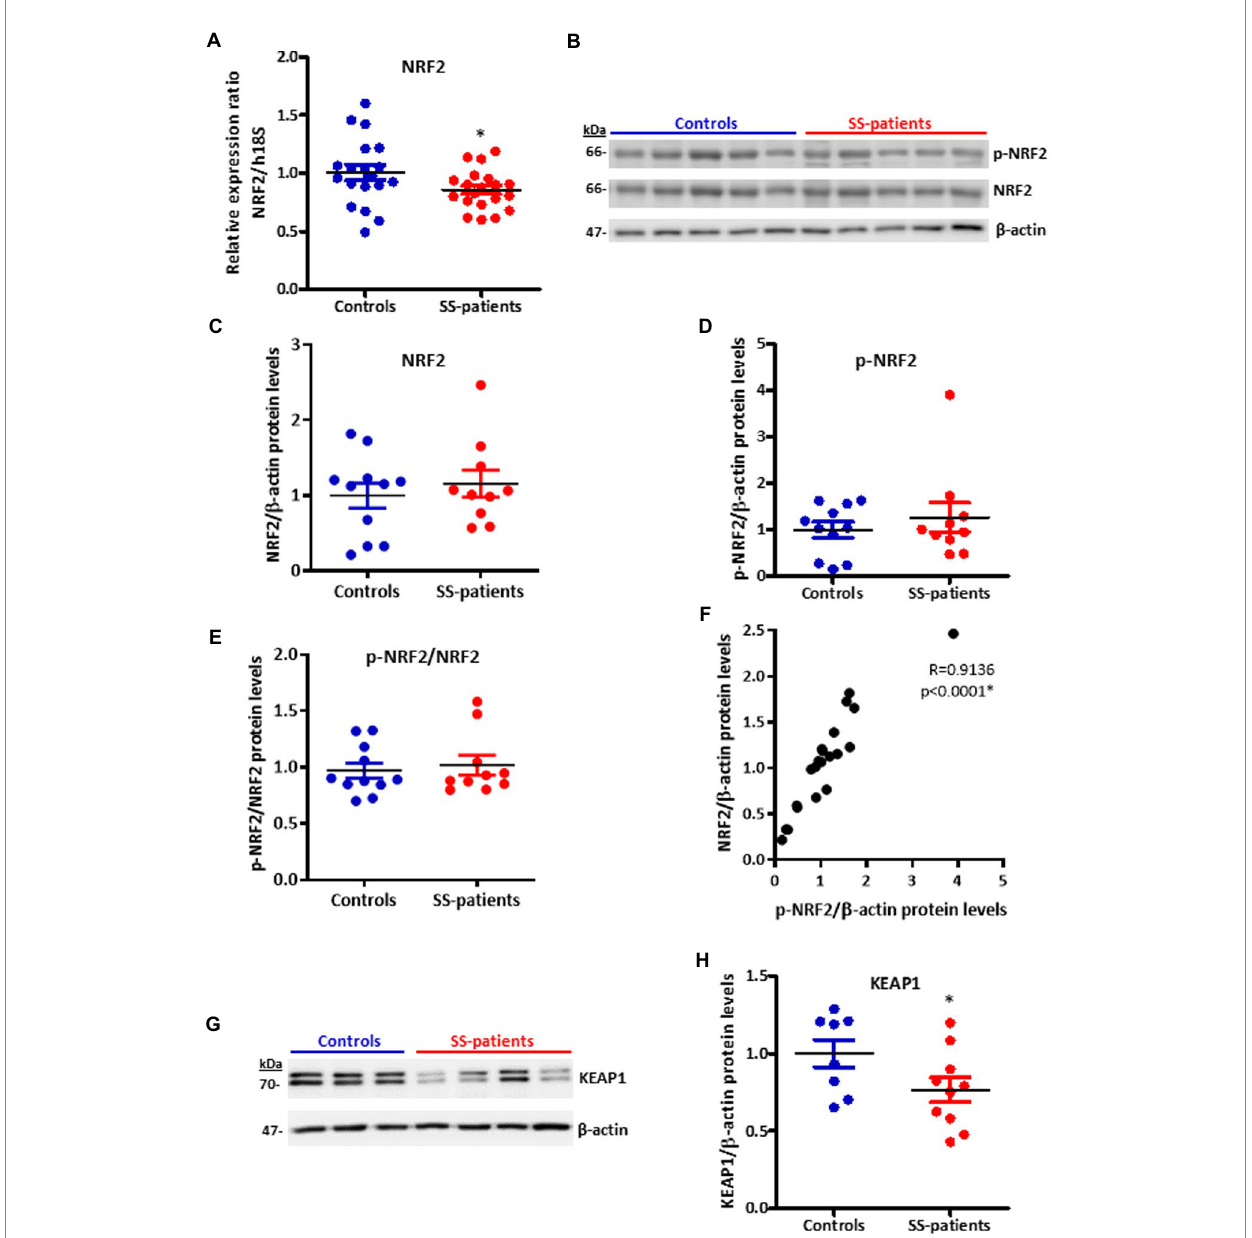
FIGURE 14 Expression of NRF2, p-NRF2, and KEAP1 in LSGs from control and SS-patients. (A) Dot plot showing NRF2 transcript levels relative to h18S from control (C) and SS-patients (P) ( n = 19C, 20P). (B) Representative images of p-NRF2 and NRF2 immunoblots from control and SS-patients using β -actin as a loading control. (C) Dot plot showing densitometric analysis of NRF2 ( n = 11C, 10P). (D) Dot plot showing densitometric analysis of p-NRF2 ( n = 11C, 10P). (E) Dot plot showing the p-NRF2/NRF2 ratio ( n = 11C, 10P). (F) Spearman’s correlation between p-NRF2 and NRF2 protein levels. (G) Representative images of KEAP1 immunoblots from control and SS-patients using β -actin as a loading control. (H) Dot plot showing densitometric analysis of KEAP1. These experiments were repeated at least three times (*). p values lower than 0.05 were considered